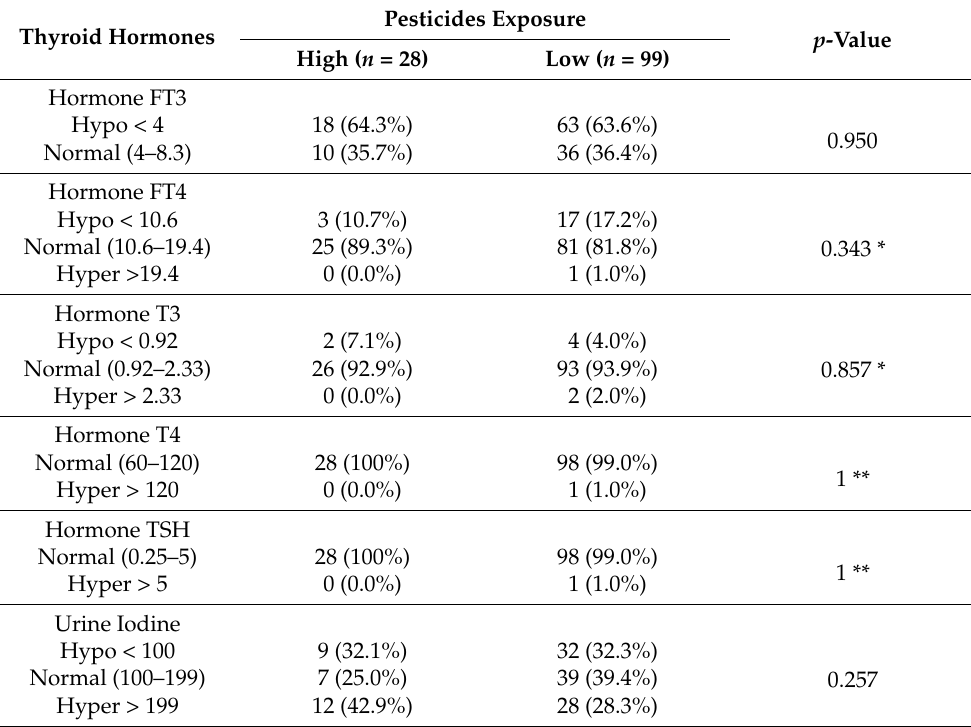
Table 5. Pesticides exposure vs. hormones and urine iodine in farmers ( n =